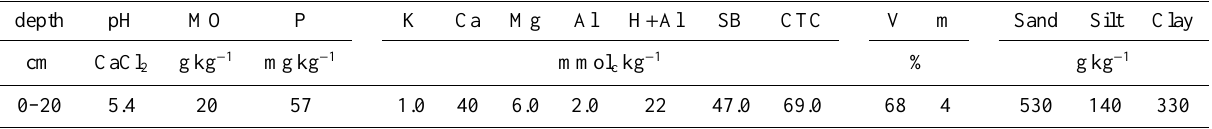
Table 1. Chemical and granulometric analyses of the typical dystrophic Red-Yellow Argisol – PVAd. Data from Gen´u et al. (2010). depth pH MO Sand Silt Clay